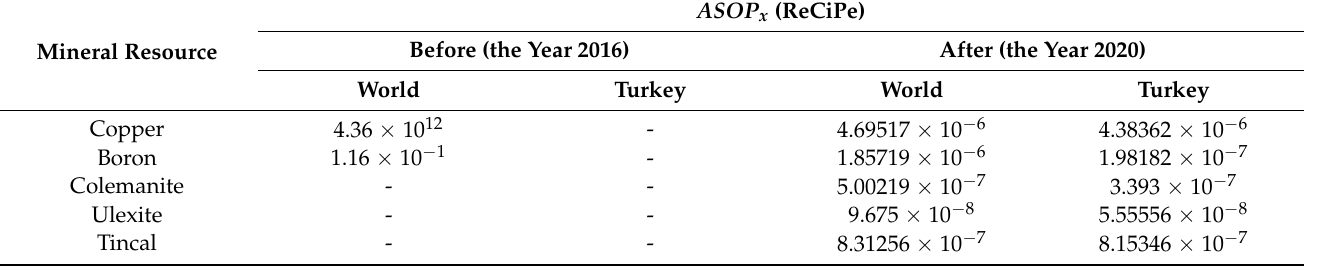
Table 8. Characterization factor that was obtained by ReCiPe method (the year 2020).